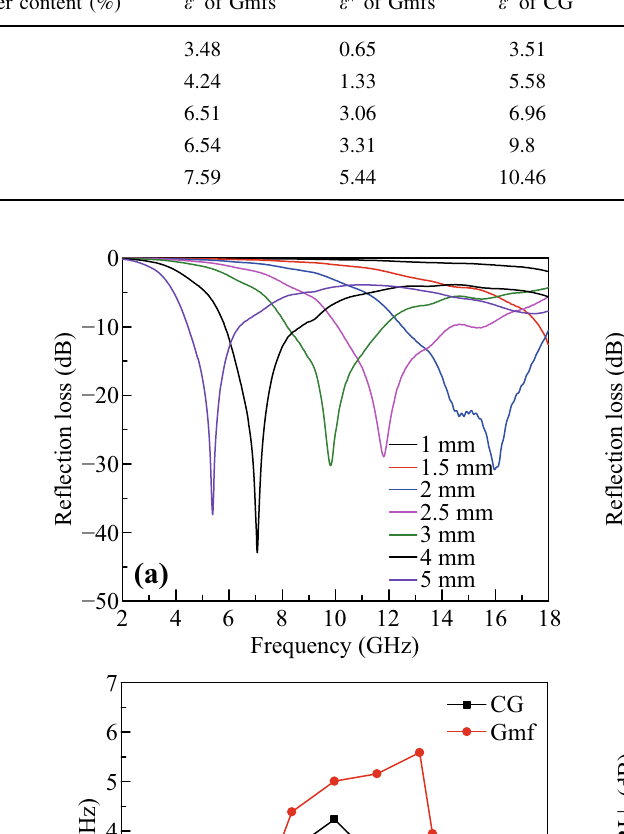
Table 1 Average parameters in the complex permittivities of Gmfs and CG in the frequency range of 8–18 GHz Filler content (%)